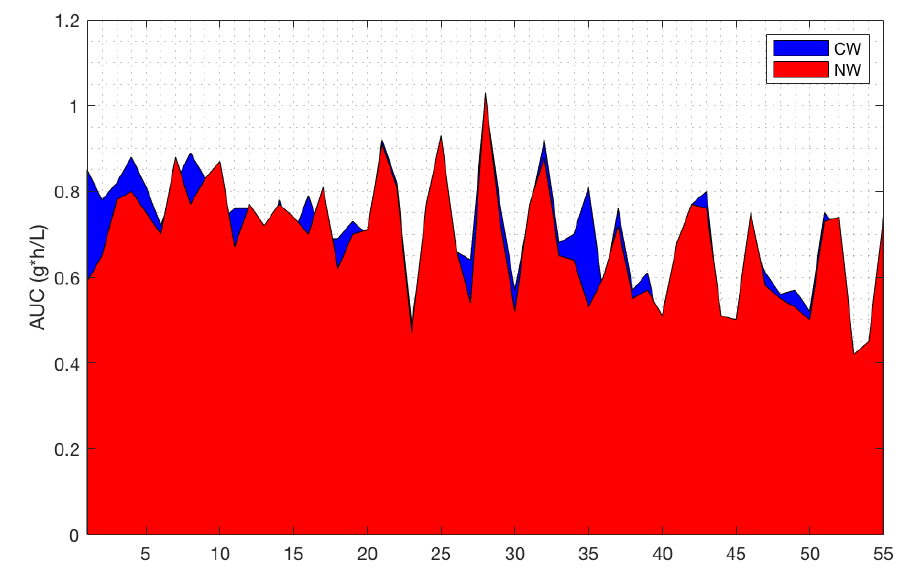
Figure 6. Area under the curve (AUC) calculated for the conventional wine (CW) and the natural wine (NW) ( p = 0.13).